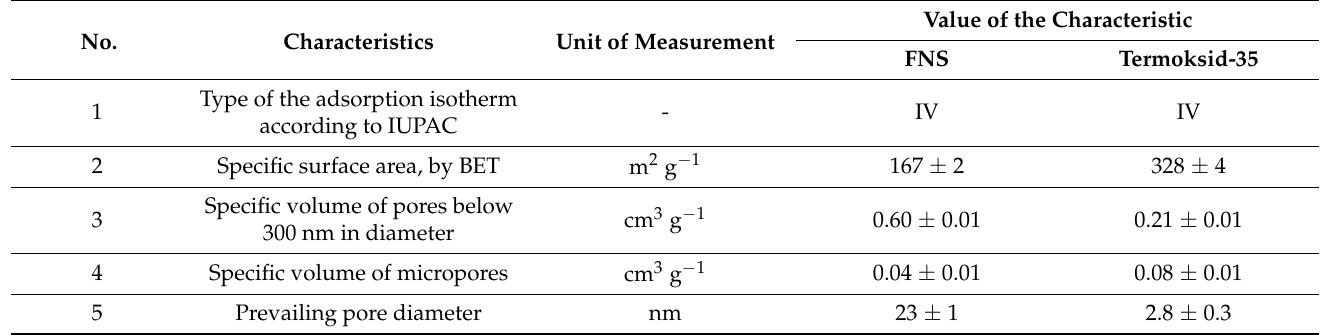
Table 2. Characteristics of the porous structure for FNS and Termoksid-35